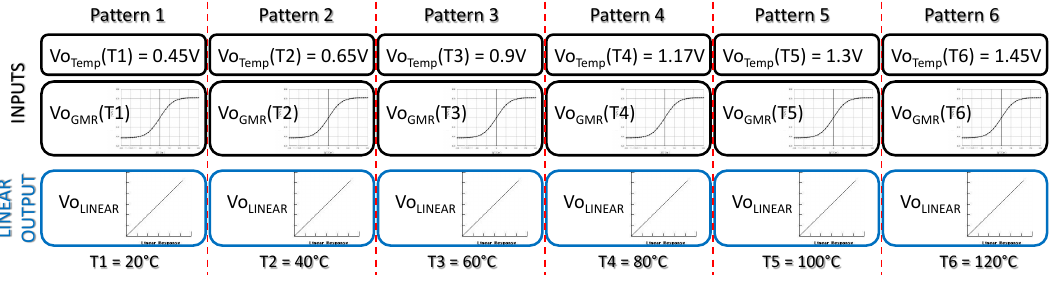
Figure 24. Defined data structure for the learning phase.